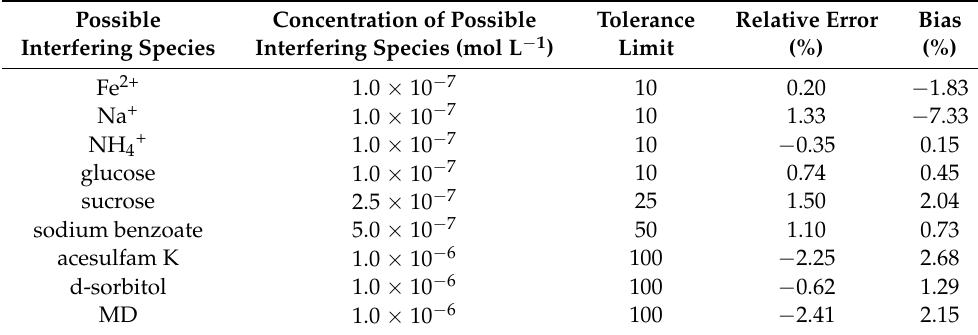
Table 2. The influence of possible interfering species on the detection of 1.0 × 10 − 8 sodium metabisul- fite (n = 4) using the TPP/rGO@Pd0 sensor.